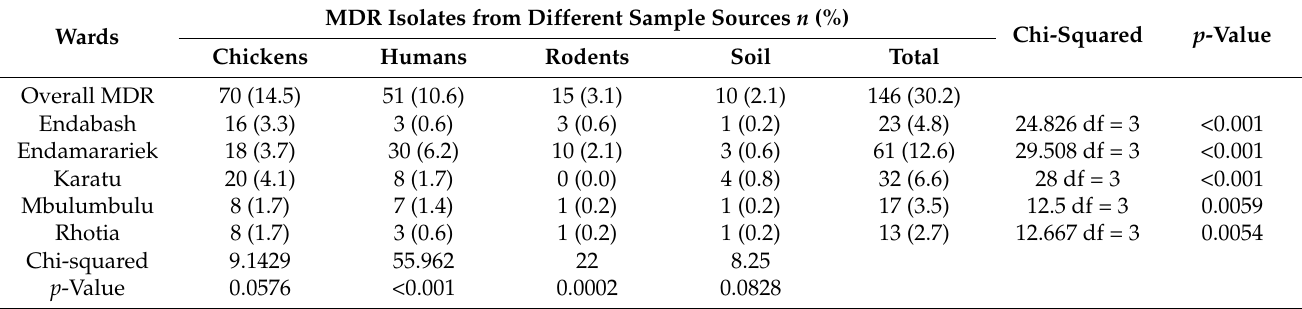
Figure 2. Distribution of MDR S. aureus isolates in different wards of Karatu. Table 4. Prevalence of MDR S. aureus isolates in different samples by